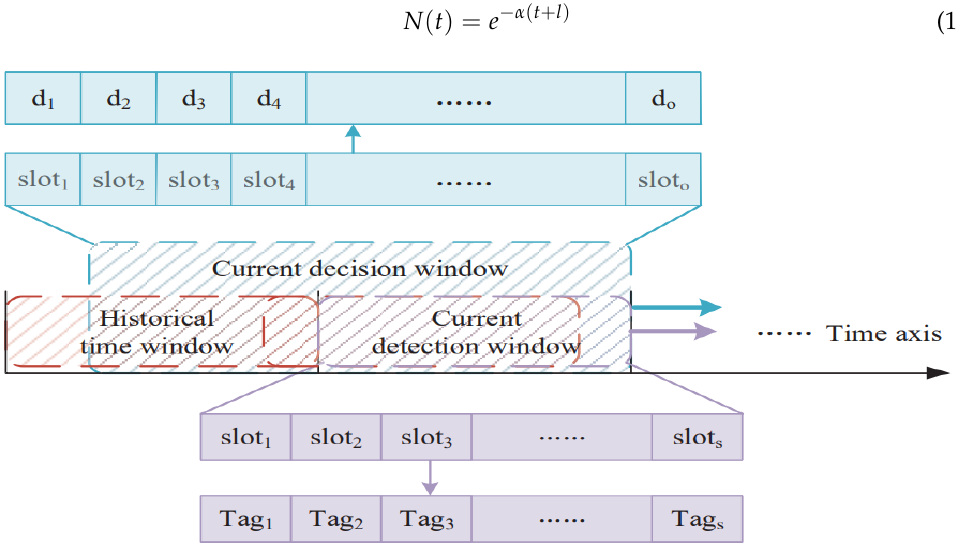
Figure 5. Schematic diagram of detection and decision sliding time window.